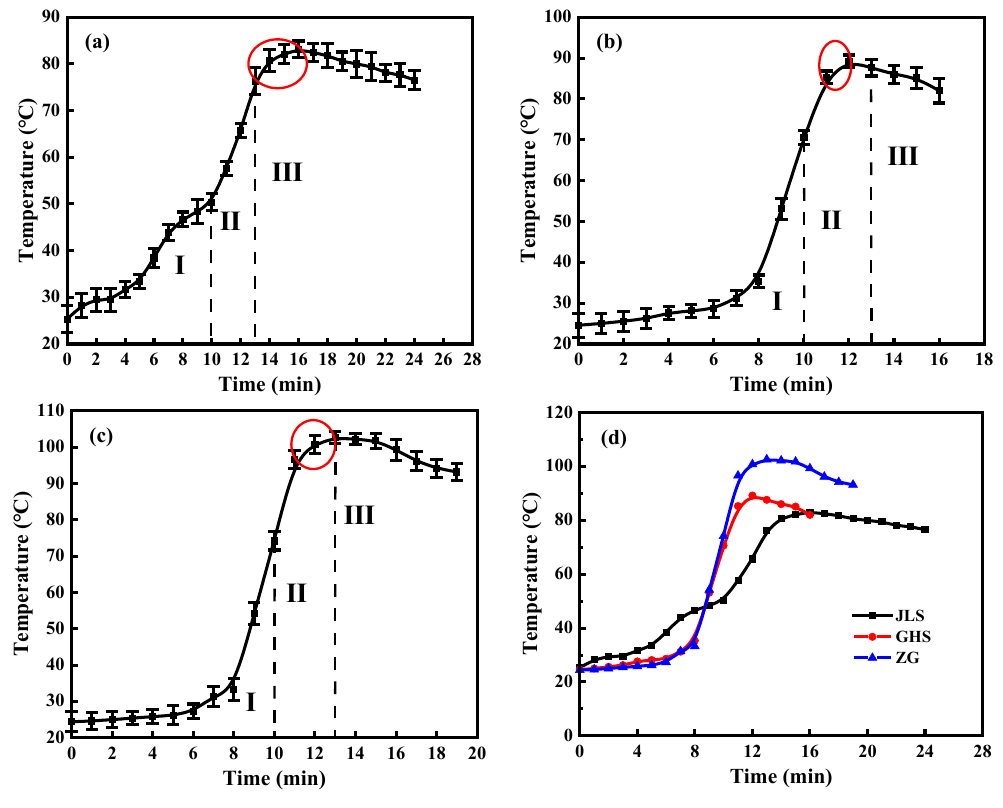
Figure 8. Temperature of measuring point on the core tube wall during coring process: ( a ) JLS; ( b ) GHS; ( c ) ZG; and ( d ) different coal mines. Table 2. Time required and temperature change rate at different stages of coring